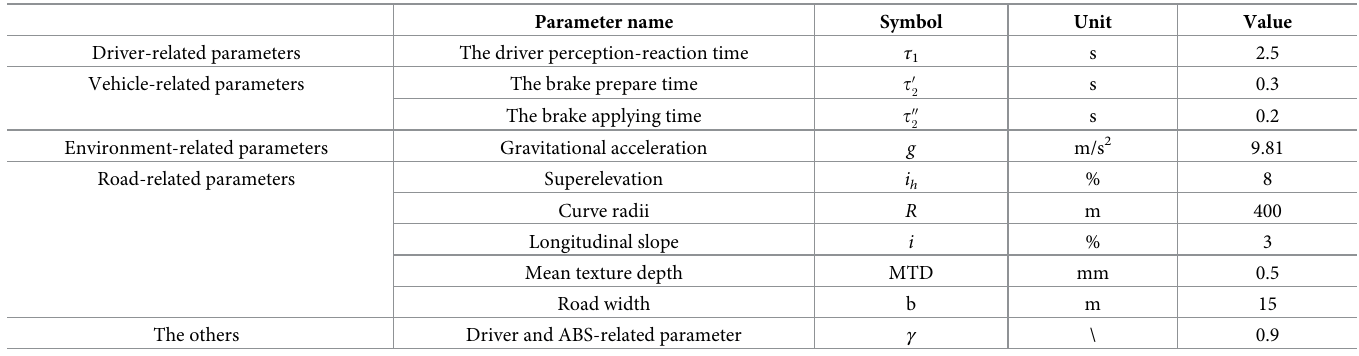
Table 3. Parameter